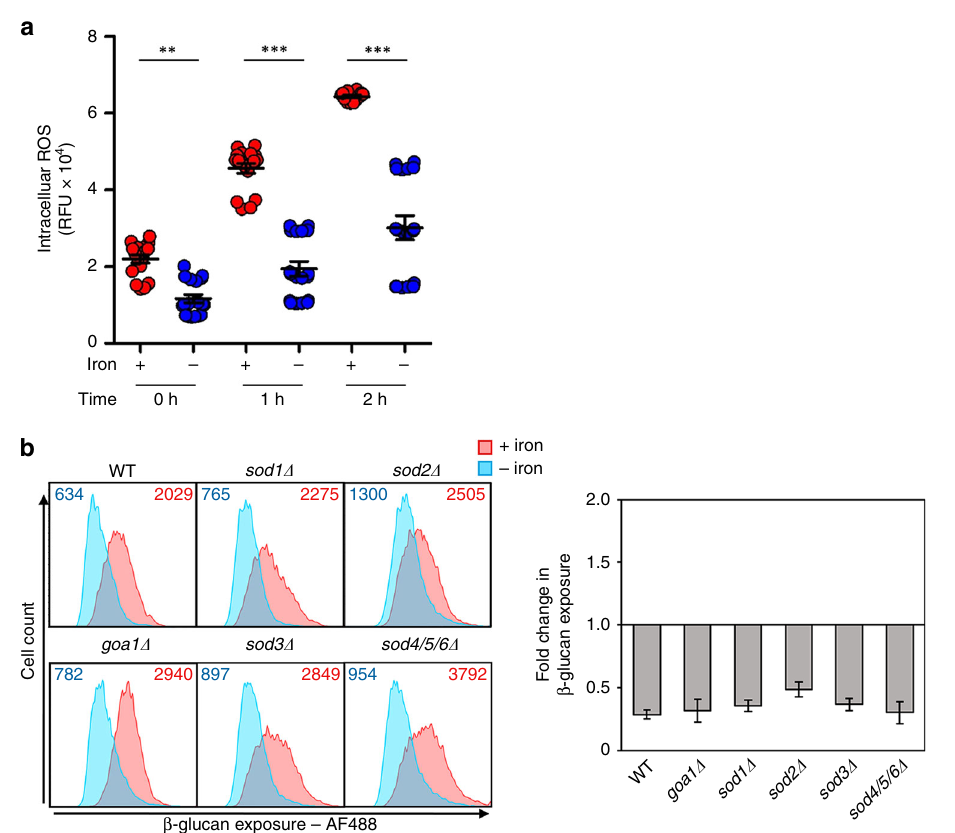
Fig. 7 Mitochondrial ROS do not trigger iron-limitation-induced β -glucan masking. a The levels of intracellular ROS levels were assayed after 0, 1 and 2 h of exposure to iron replete (red) or iron-limiting conditions (blue). C. albicans SC5314 cells were stained with 10 µ M DCFH-DA for 15 min and, after excitation at 485 nm, cellular fl uorescence emission quanti fi ed at 535 nm (relative fl uorescence units, RFU). The data, which represent means and standard deviations from fi ve technical replicates from three independent experiments, were analysed using ANOVA with Tukey ’ s multiple comparison test: * p < 0.05; ** p < 0.01; *** p < 0.001. b C. albicans strains were exposed to iron replete (pink) or iron-deplete conditions (cyan) for 5 h, fi xed and stained with Fc- dectin-1, and their levels of β -glucan exposure quanti fi ed by cytometry: WT, SC5314; sod1 Δ , CA-IF003; sod2 Δ , CA-IF007; sod3 Δ , CA-IF011 single mutants; sod4/5/6 Δ triple mutant, CA-IF070; goa1 Δ , GOA31 (Supplementary Table 1). Median fl uorescence intensities (MFIs) for the iron replete and iron deplete cell populations are shown. The right-hand panel shows the fold change in β -glucan exposure for each strain, calculated by dividing the MFI under iron- limiting conditions by the MFI for the corresponding control iron-replete cells. Means and standard deviations from three independent replicate experiments are shown, and the data were analysed using ANOVA with Tukey ’ s multiple comparison test. None of the changes were signi fi cant at p < 0.05. Source data are provided as a Source Data fi